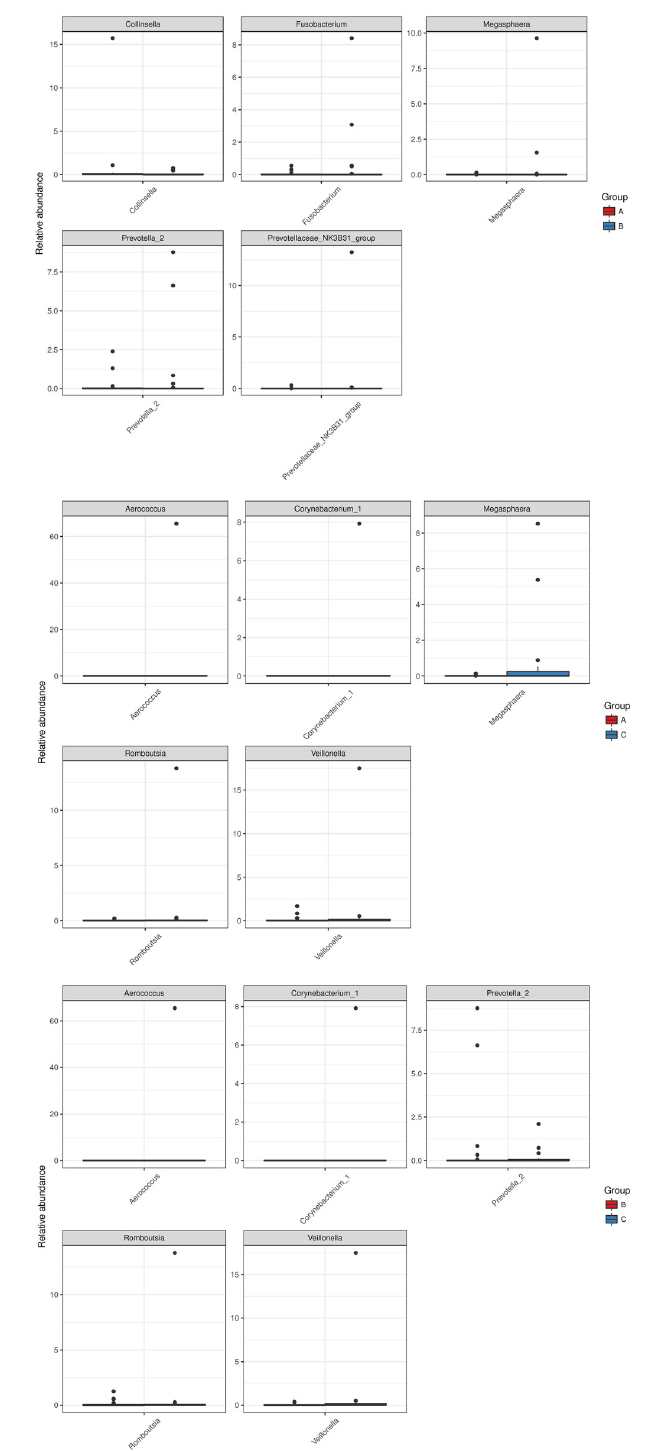
Fig 5. Abundance distributions of the five genera with the largest between-group differences. Top: group A vs. group B; middle: group A vs. group C; bottom: group B vs. group C.